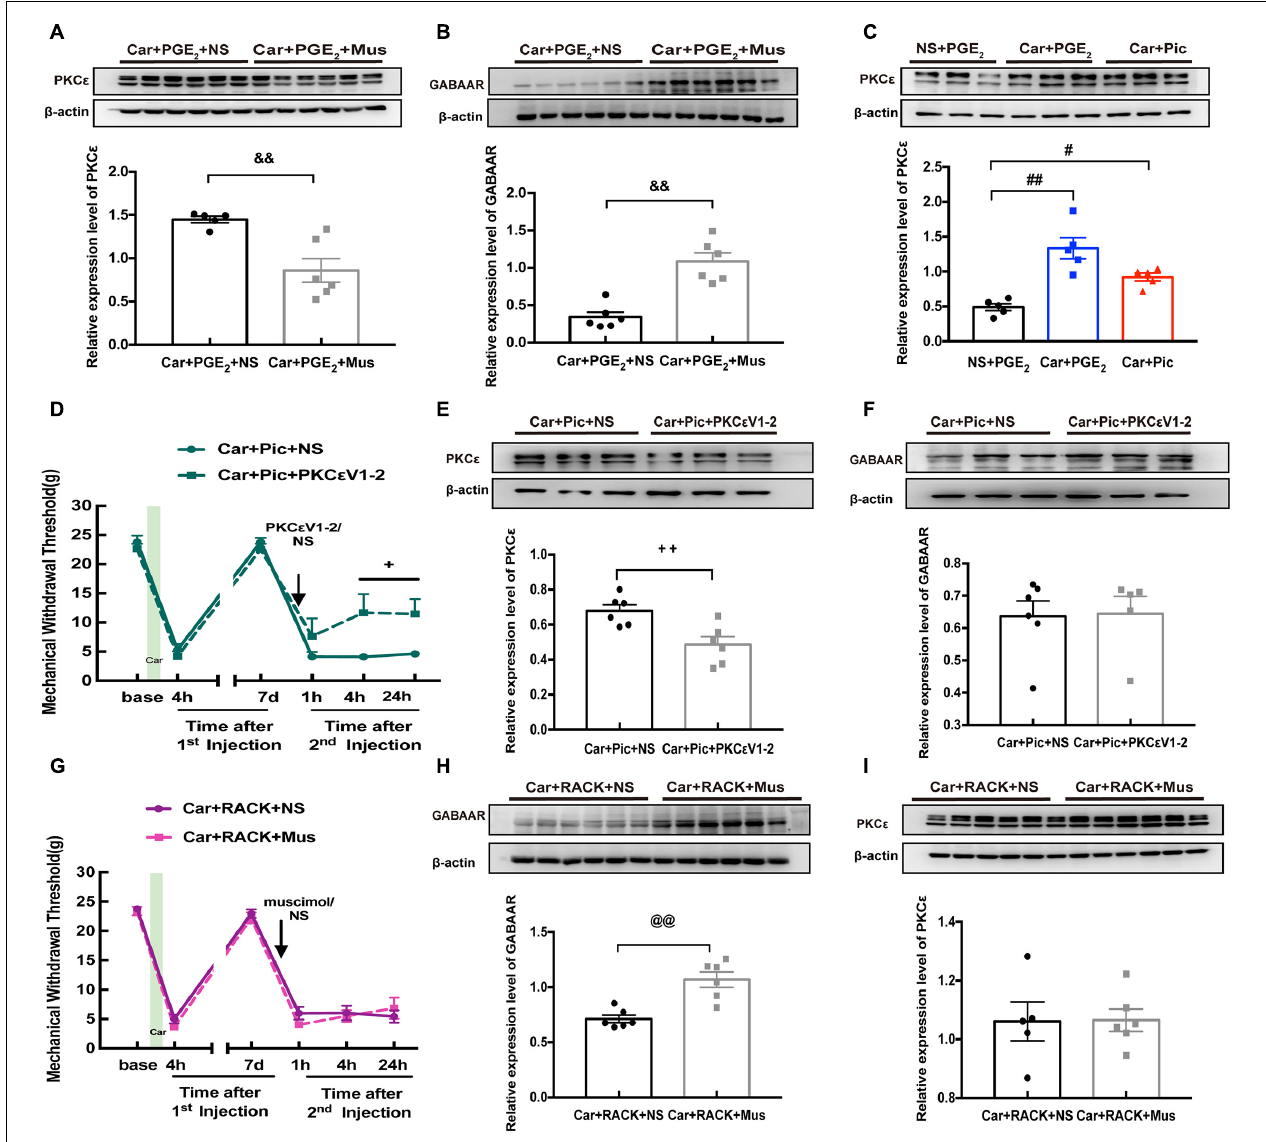
FIGURE 4 | The relationship between GABAAR and PKC ε in L4-6 DRGs of hyperalgesic priming rats. The quantification of the Western blots results and a representative Western blot showing PKC ε (A) and GABAAR (B) protein isolated from the L4-L6 DRG 24 h after 2nd injection. The Muscimol (10 µ M/25 µ L/paw) was administrated 10 min before PGE 2 injection. (C) The quantification of the Western blots results and a representative Western blot showing PKC ε protein isolated from the DRG 24 h after 2nd injection. The Picrotoxin (1 µ M/25 µ L/paw) was administrated instead of PGE 2 . (D) Injection of PKC ε V1-2 (1 µ g/25 µ L/paw) reversed the long-lasting hyperalgesia induced by Picrotoxin injection following by carrageenan. The quantification of the Western blots results and a representative Western blot showing PKC ε (E) and GABAAR (F) protein isolated from the DRG 24 h after 2nd injection. (G) Muscimol injected 10 min before 2nd injection failed to regulate the hyperalgesic priming produced by ψε RACK (1 µ g/25 µ L/paw) injection following carrageenan. The quantification of the Western blots results and a representative Western blot showing PKC ε (H) and GABAAR (I) protein isolated from the DRG 24 h after 2nd injection. Data are presented as mean ± SEM, n = 6; && P < 0.01